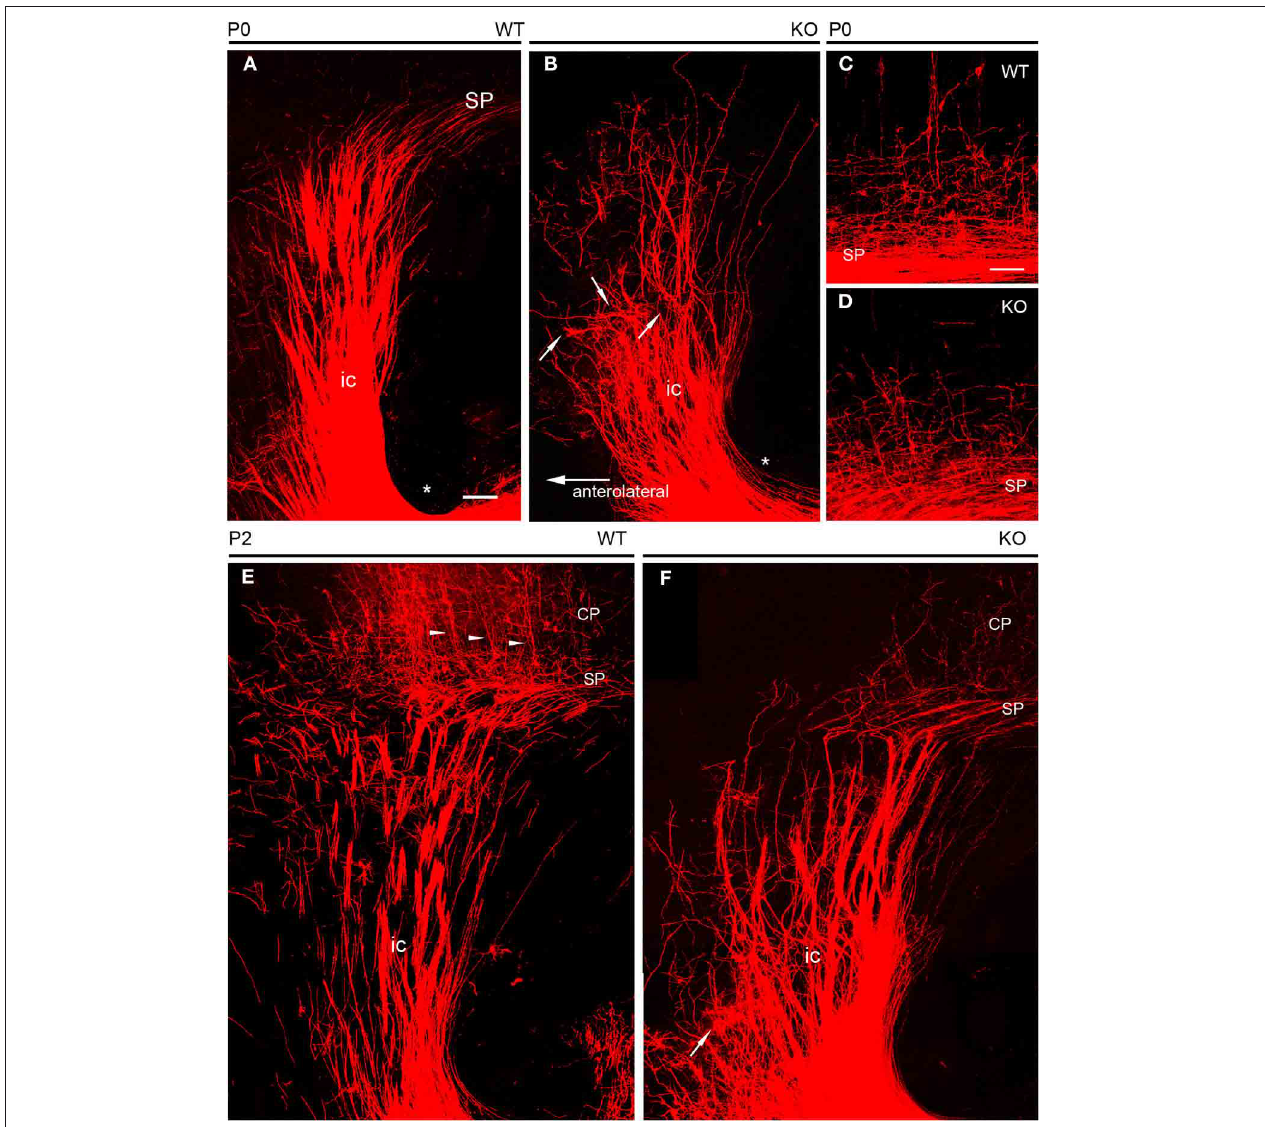
FIGURE 5 | DiI tracing of thalamocortical fibers at early postnatal ages. (A,B) At P0, thick fascicles of DiI-labeled TC axons traversed the ventral telencephalon in their way to the developing cortex. The course of TC axons along the internal capsule was straight in wild type embryos (A) , where few axon collaterals dispersed laterally. In null mutant mice (B) , TC axon fascicles in the lateral parts of the pathway bent abruptly, failing to reach the cortex; arrows point at selected examples of dispersed axon fascicles. Axons at more medial locations, although less dispersed, navigated in a disorderly manner, giving rise to abundant axon collaterals in the ventral telencephalon. Asterisks in A and B mark the inferior level of the internal capsule in the